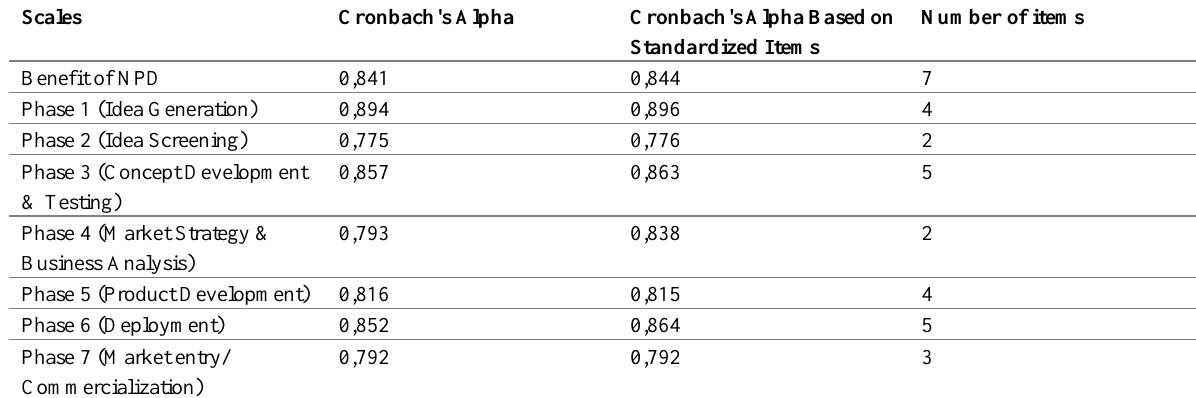
Table 1: Reliability Statistics of Measurement Scales